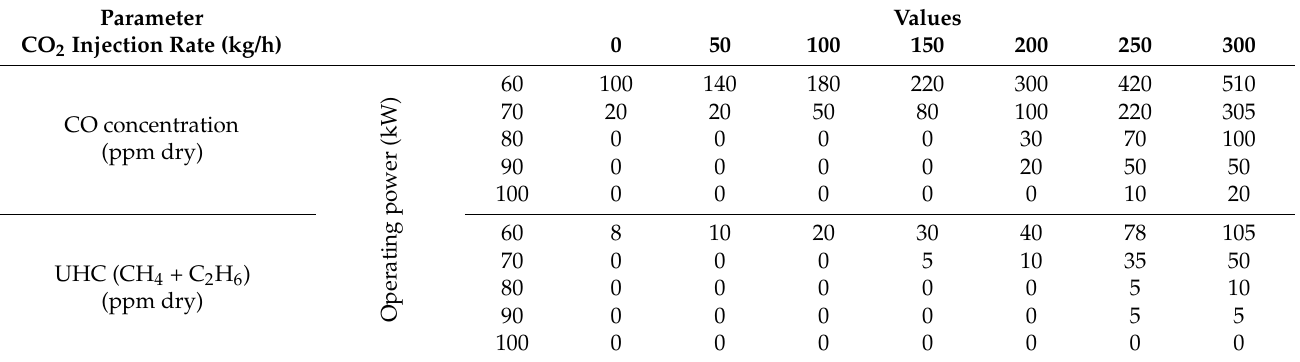
Table 4. Effect of CO 2 injection rates for the given operating envelope (60–100 kW) on CO and UHC emission concentrations (adapted from